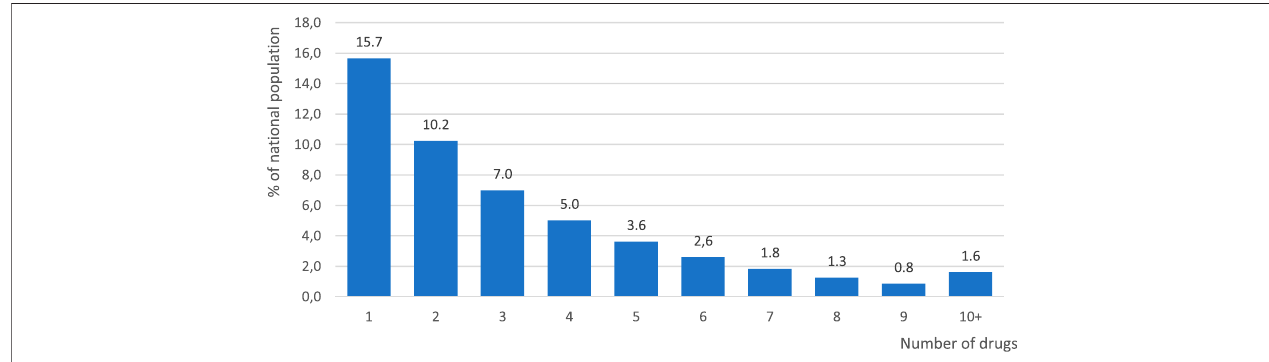
FIGURE1| Distribution ofthenumbersofreimbursed drugsholdingvariousactivesubstancesdispensed topatientsaccordingtoprescriptionsinPolandin2018. Note: Numbers calculated for the drugs dispensed within six months from the fi rst dispensation in the calendar year.